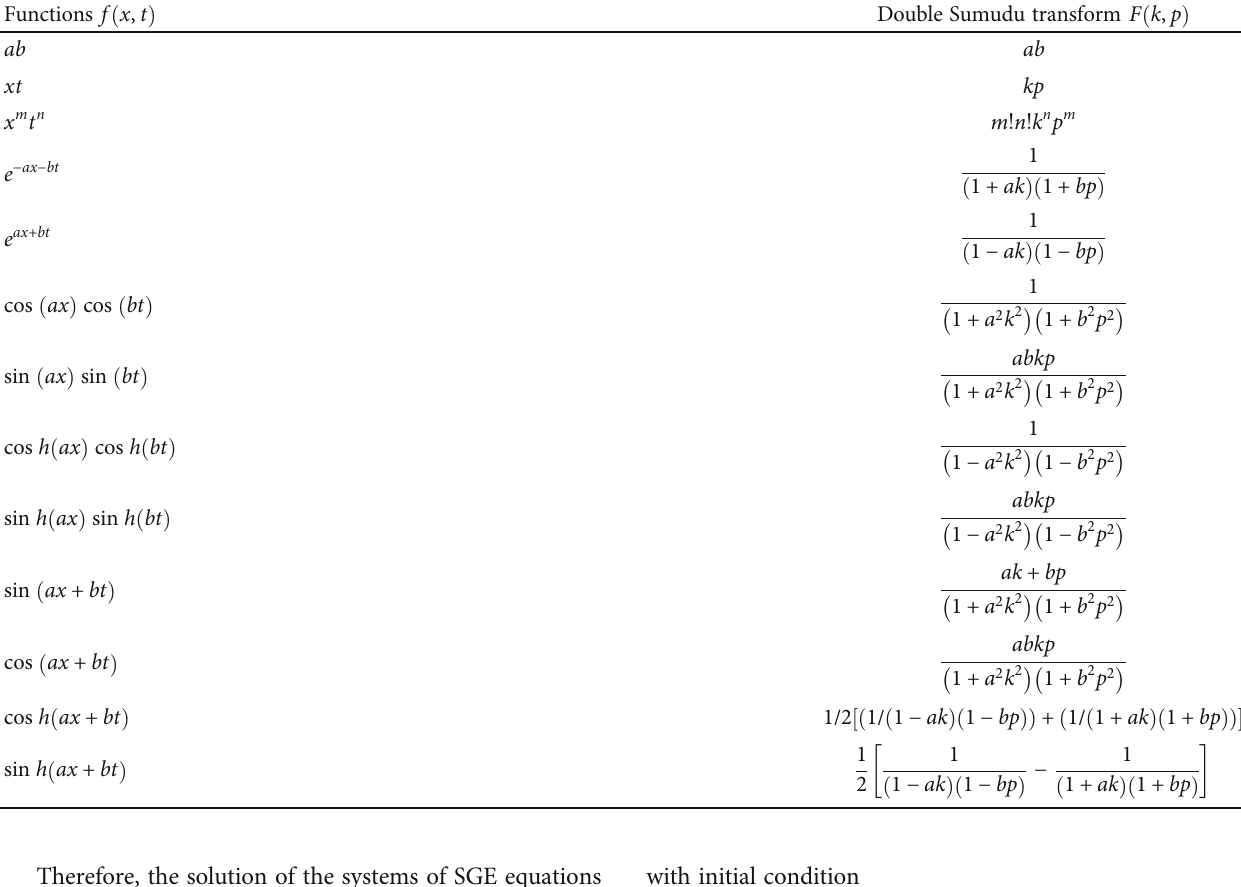
Table 1: Double Sumudu transforms of some functions of two variables [30, 41, 45, 46]. Functions f x , t